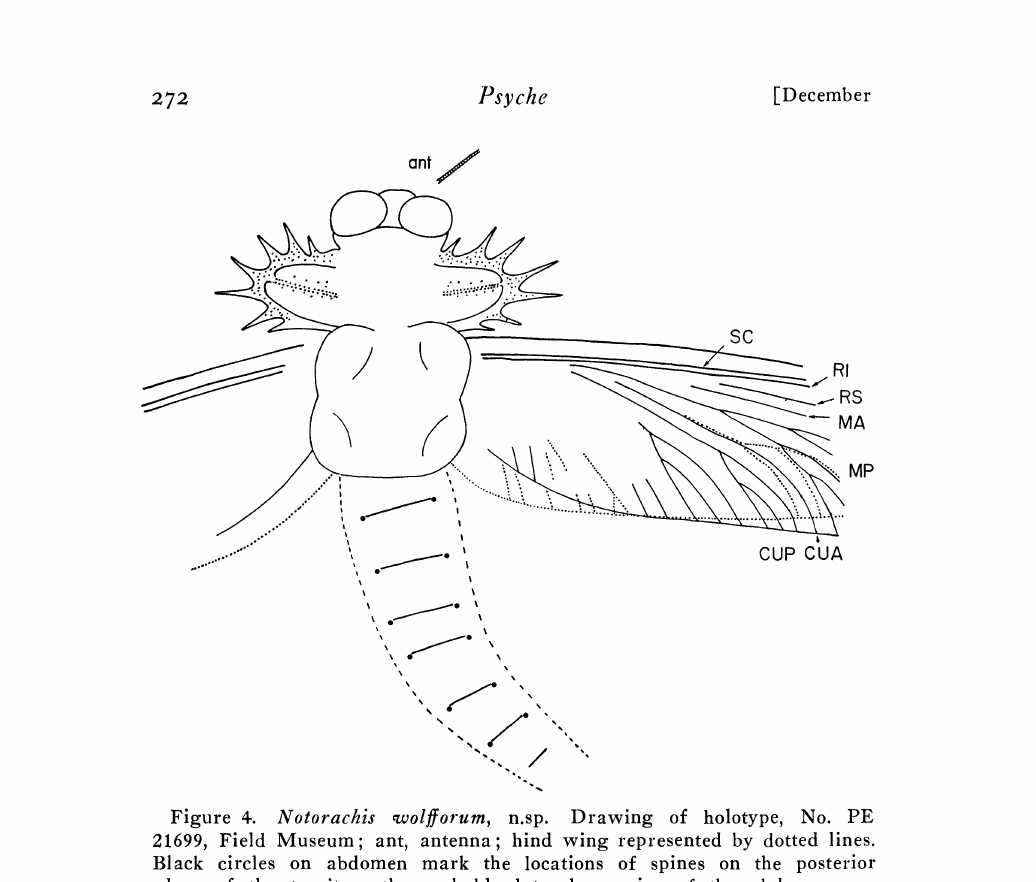
Figure 4. Notorachis wolfforum, n.sp. Drawing ot holotype, No. PE 21699, Field Museum; ant, antenna; hind wing represented by dotted lines. Black circles on abdomen mark the locations of spines on the posterior edges ot the tergites; the probable lateral margins ot the abdomen are indicated by broken